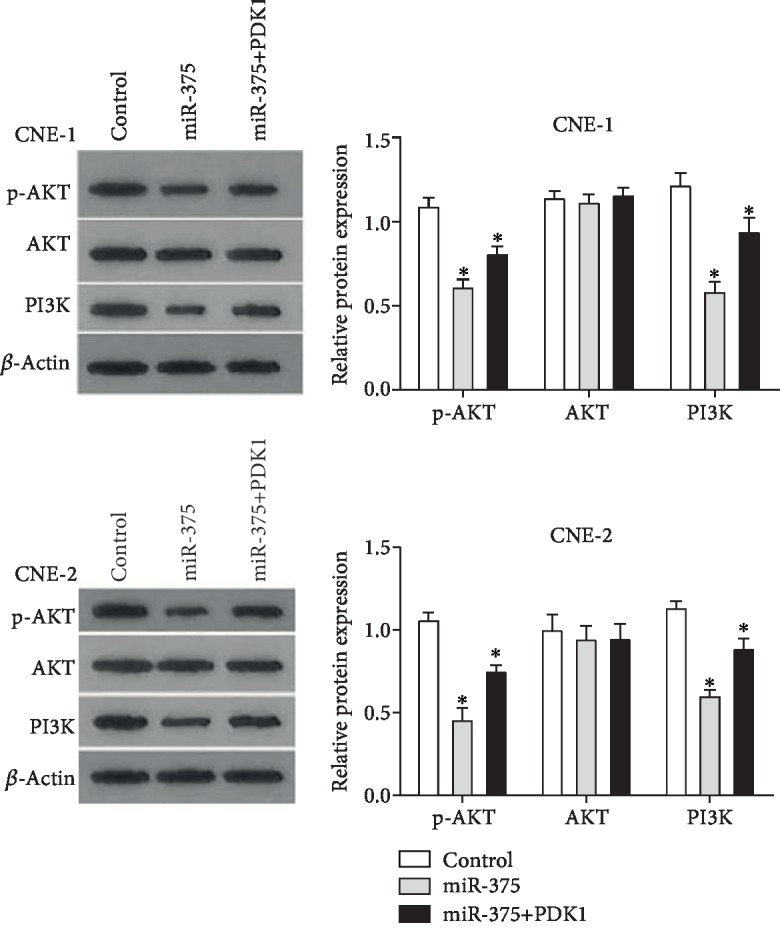
miR-375-mediated suppression of NPC cell progression is eliminated upon recovery of PDK1 expression. Western blot was performed to measure protein levels of AKT, p-AKT, P13K, and P13K in CNE-1 and CNE-2 cells.